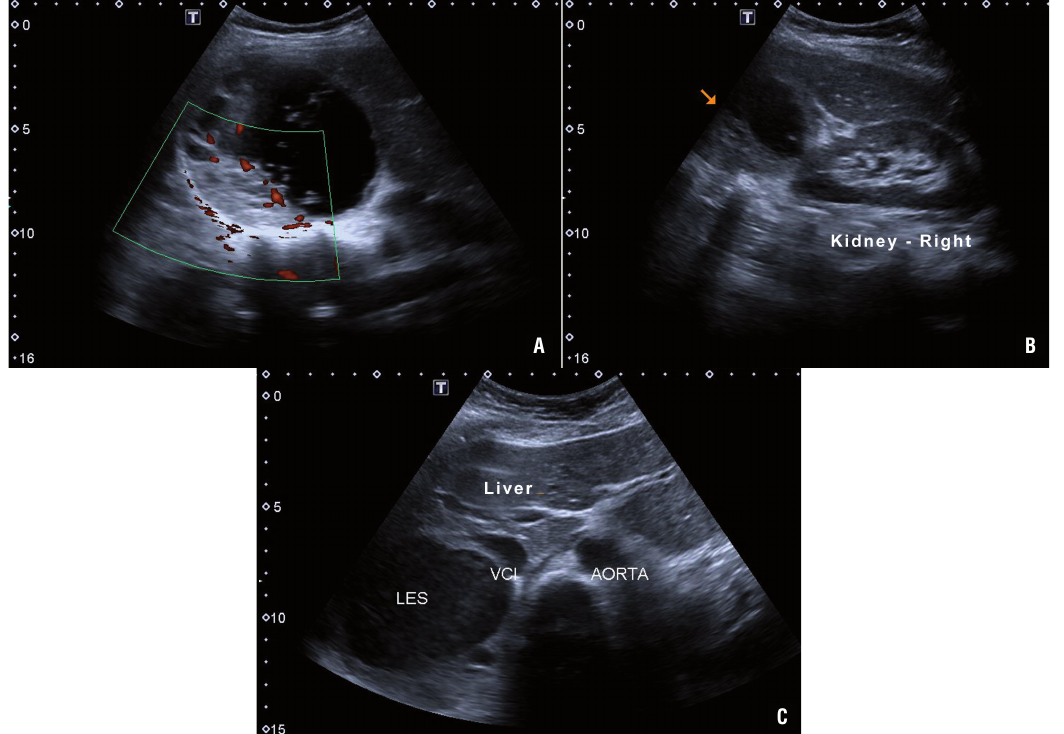
figure 1 - A) Ultrasound showing right adrenal tumor with more than 10 centimeters, with mixed cystic-solid components and doppler imaging confirm the presence of vascular flow; B) Arrow indicating the great mass between the liver (Liver) and the right kidney (Kidney - right ); c) pheochromocytoma (LES) by compressing and pushing the inferior vena cava